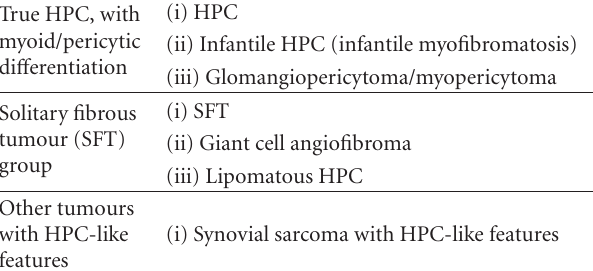
Table 1: The current partition of the old-term “hemangiopericy- toma”